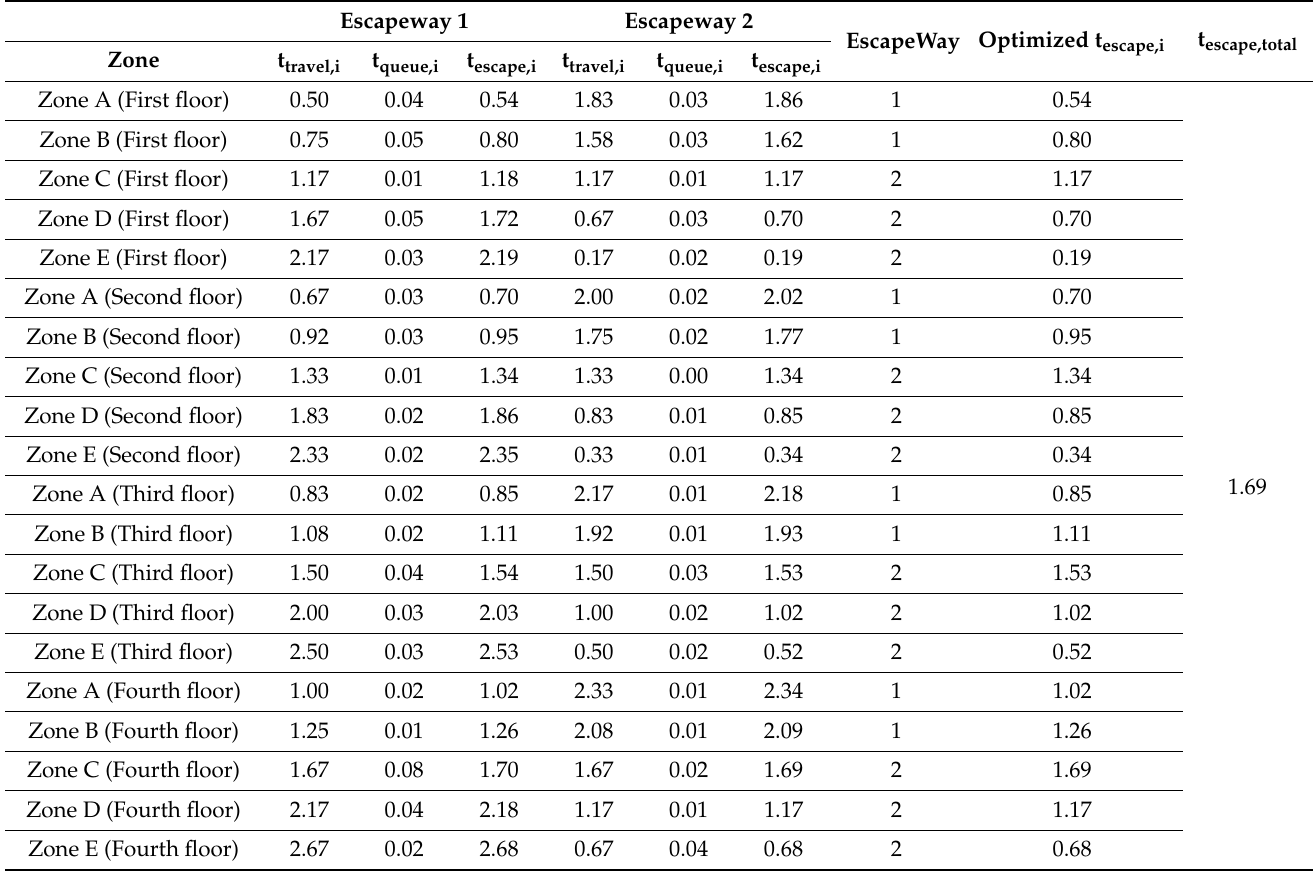
Table 4. Escape route optimization results of the reference case.